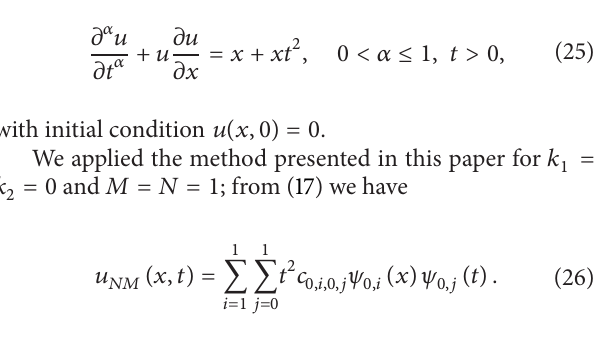
according to different values of 𝛼 . Figure 4 shows a plot of 𝑢(𝑥, 𝑡) for various values of 𝑡 and different values of 𝛼 , 𝑥 = 1